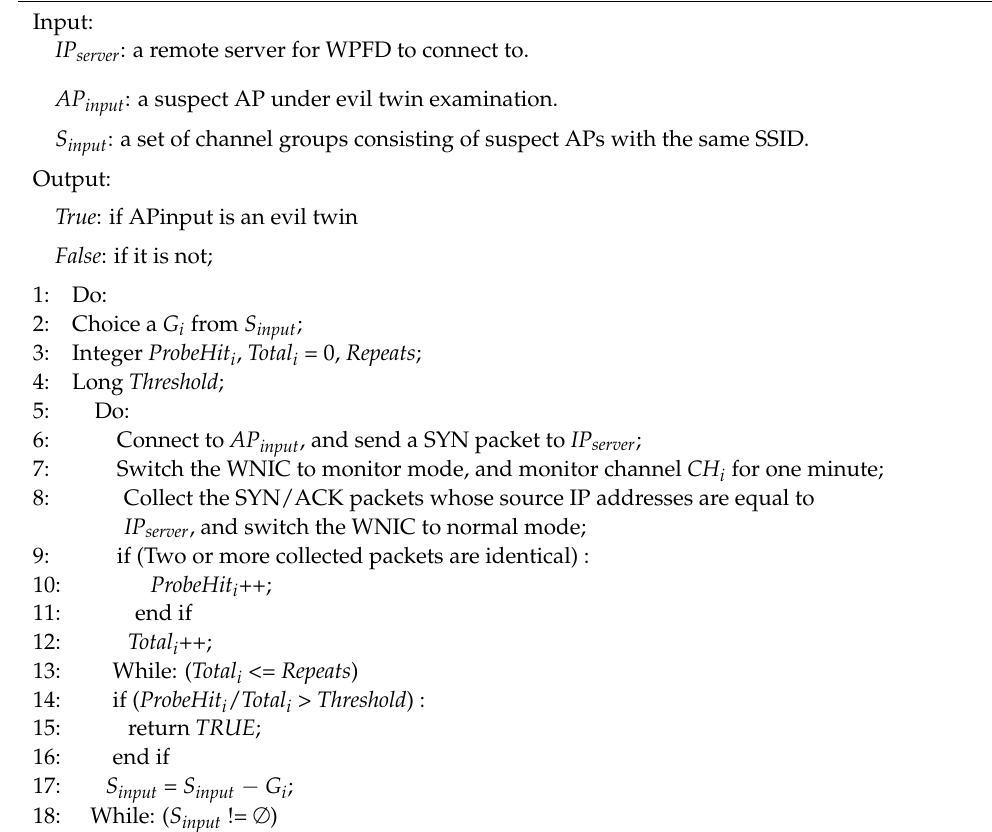
Algorithm 1: Wireless Packet Forwarding